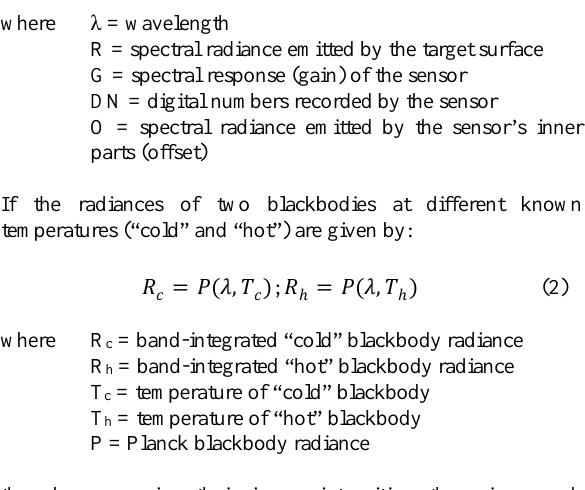
Figure 6. Central, top left, top right and bottom right corner image values of a blackbody heated to a wide range of temperatures prior to (upper) and after (lower) calibration. In order to check the effectiveness of the derived corrections, they were applied to a separate set of the imagery of a blackbody at a known temperature, which was used to investigate temperature drift over time (section 3.1). As presented in Figure 7, the applied correction accounted for an overestimation (>1 K) in the average temperature readings; the imagery are now representing the actual blackbody temperature with maximum offsets of ± 0.23 K (once sensor stabilisation is